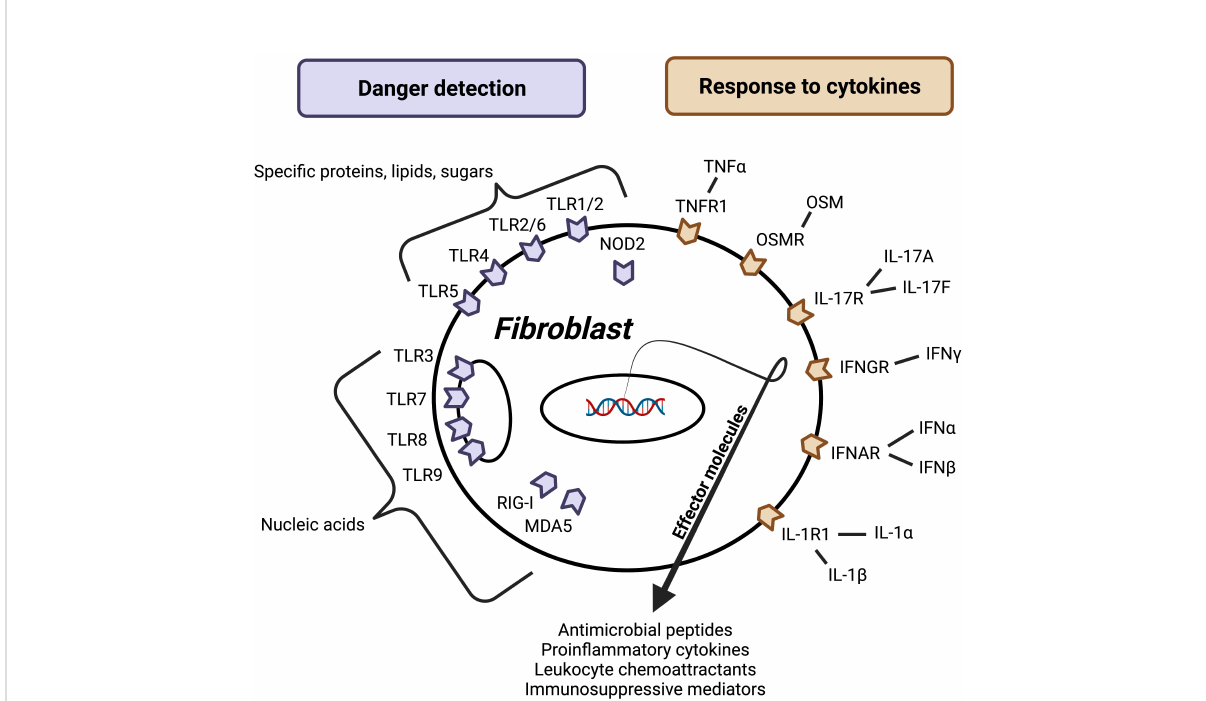
FIGURE 2 Factors regulating fi broblast effector function. Barrier tissue fi broblasts sense danger and respond to cytokines, leading to activation and release of effector molecules. Danger signals may be microbe- or host-derived and detected using surface, cytosolic, or endosomal receptors (purple). While these receptors can broadly be divided into a group that recognizes nucleic acids and group that recognizes certain molecules composed of proteins, lipids, and/or sugars, each receptor has evolved to recognize a unique set of ligands. Host-derived soluble protein signals called cytokines activate surface receptors (orange). Importantly, this fi gure represents a synthesis of barrier tissue fi broblast activating signals; more research is needed to understand how fi broblast activation varies between different fi broblast populations. Additionally, more work is needed to identify negative regulators and understand how other signals like neuronal factors, lipid mediators, and hormones impact barrier tissue fi broblast effector